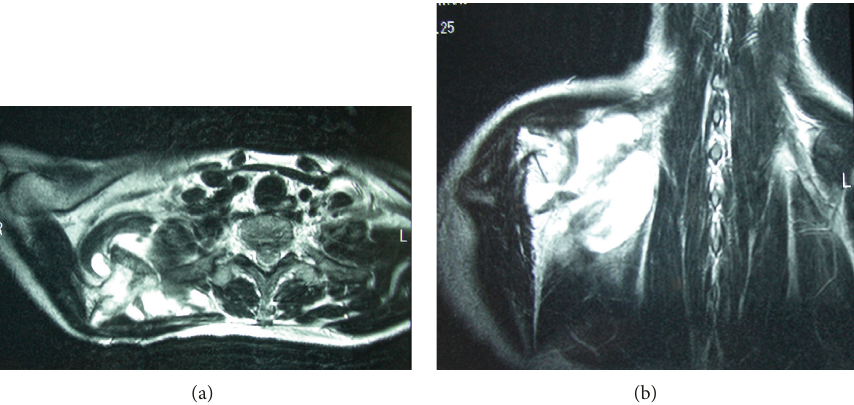
Figure 3: Preoperative T2-weighted magnetic resonance imaging. (a) Axial view demonstrated the cystic lesion containing a large amount of fluid that surrounded the osseous tumor. (b) Coronal view revealed that the cystic lesion spread over the upper two-thirds of the scapula.